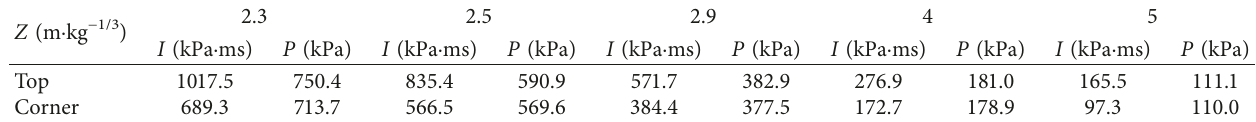
Table 5: Results of parameter analysis with different scaled distances.